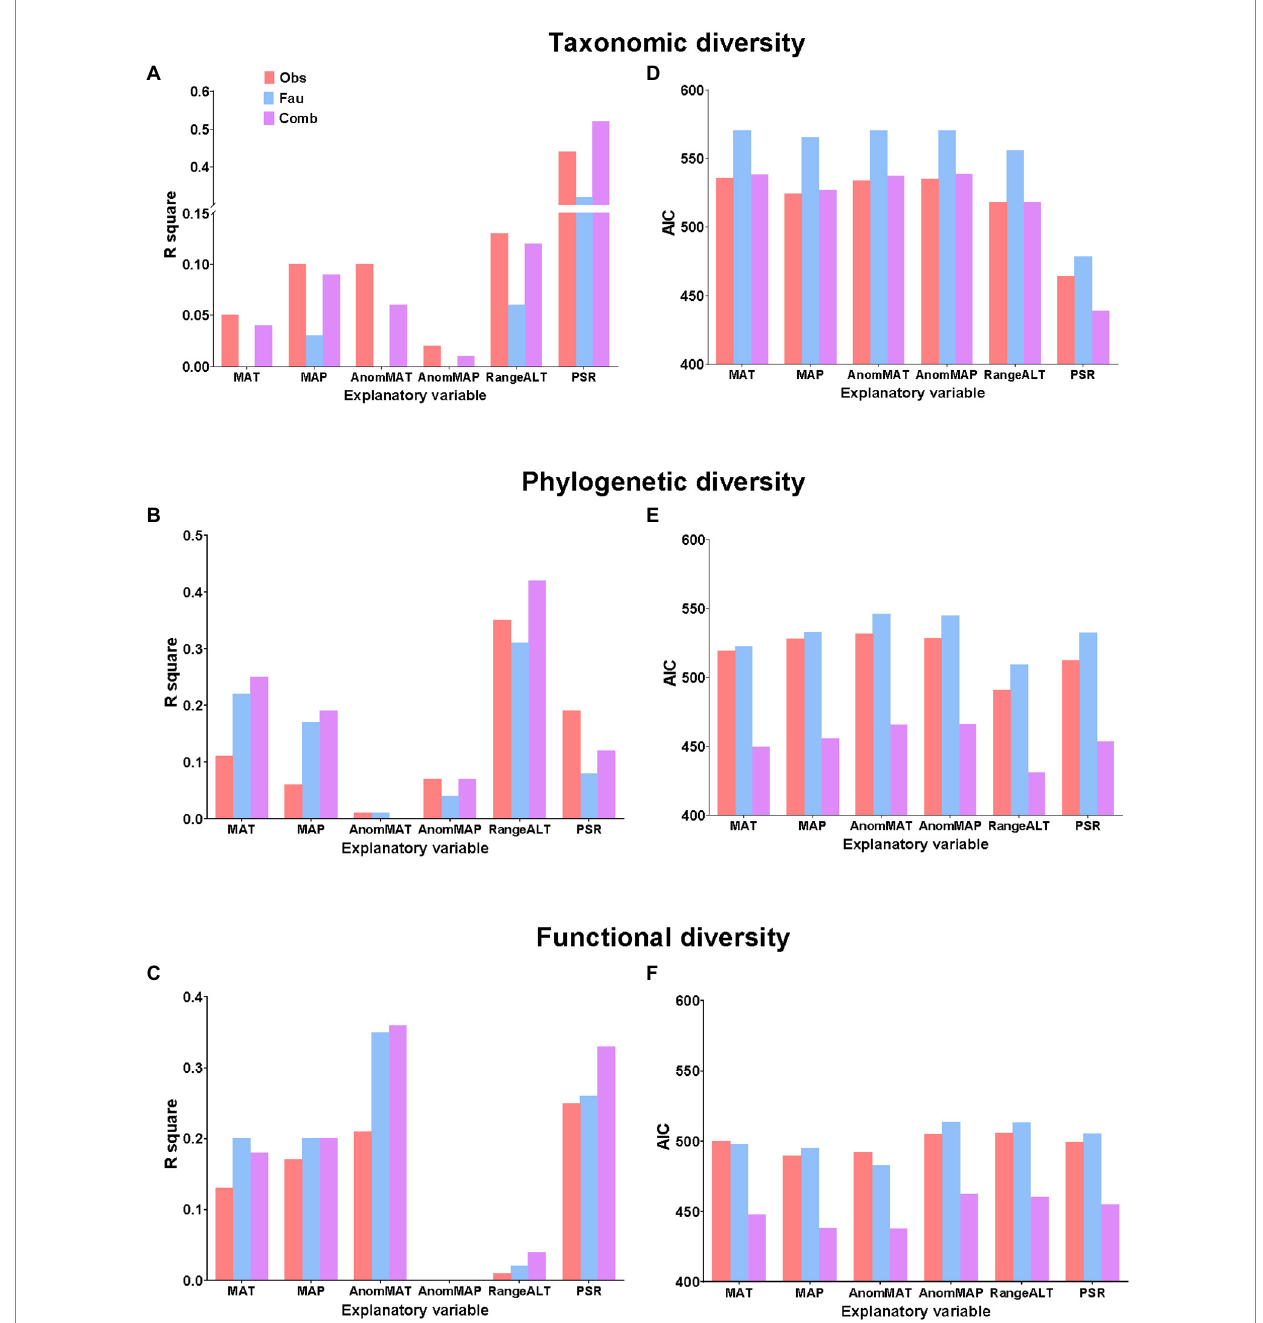
FIGURE 2 Relationship between each diversity index and environmental factor in observational (Obs), avifauna (Fau), and combined datasets (Comb), comparing (A–C) the R 2 s in the OLS models and (D–F) Akaike information criterions (AICs) in the spatial simultaneous autoregressive (SAR) models of taxonomic diversity, phylogenetic diversity, and functional